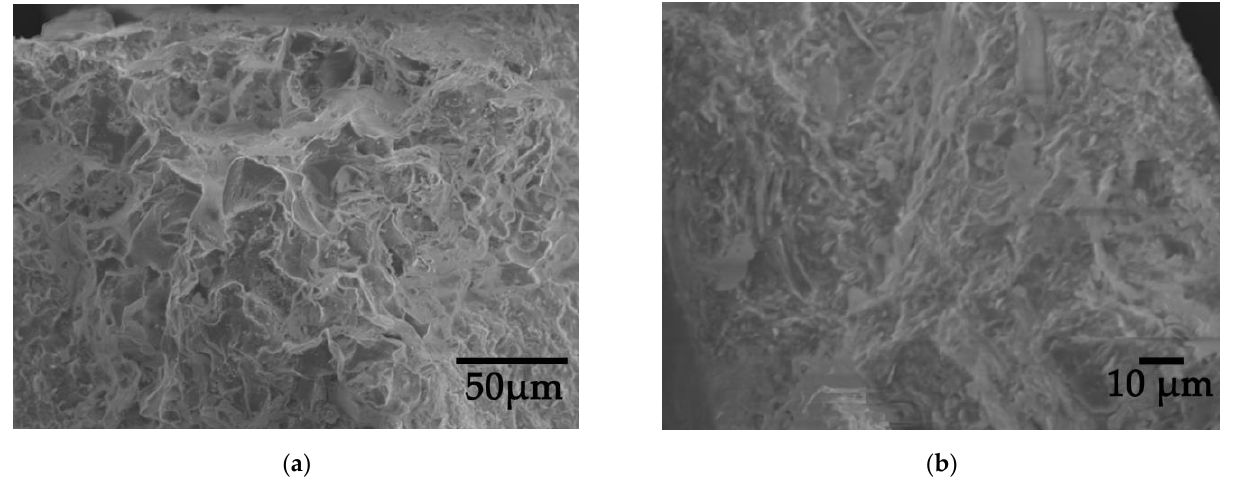
Figure 4. SEM images of sample G1 ( a ) at 500× magnification; ( b ) at 1000× magnification.